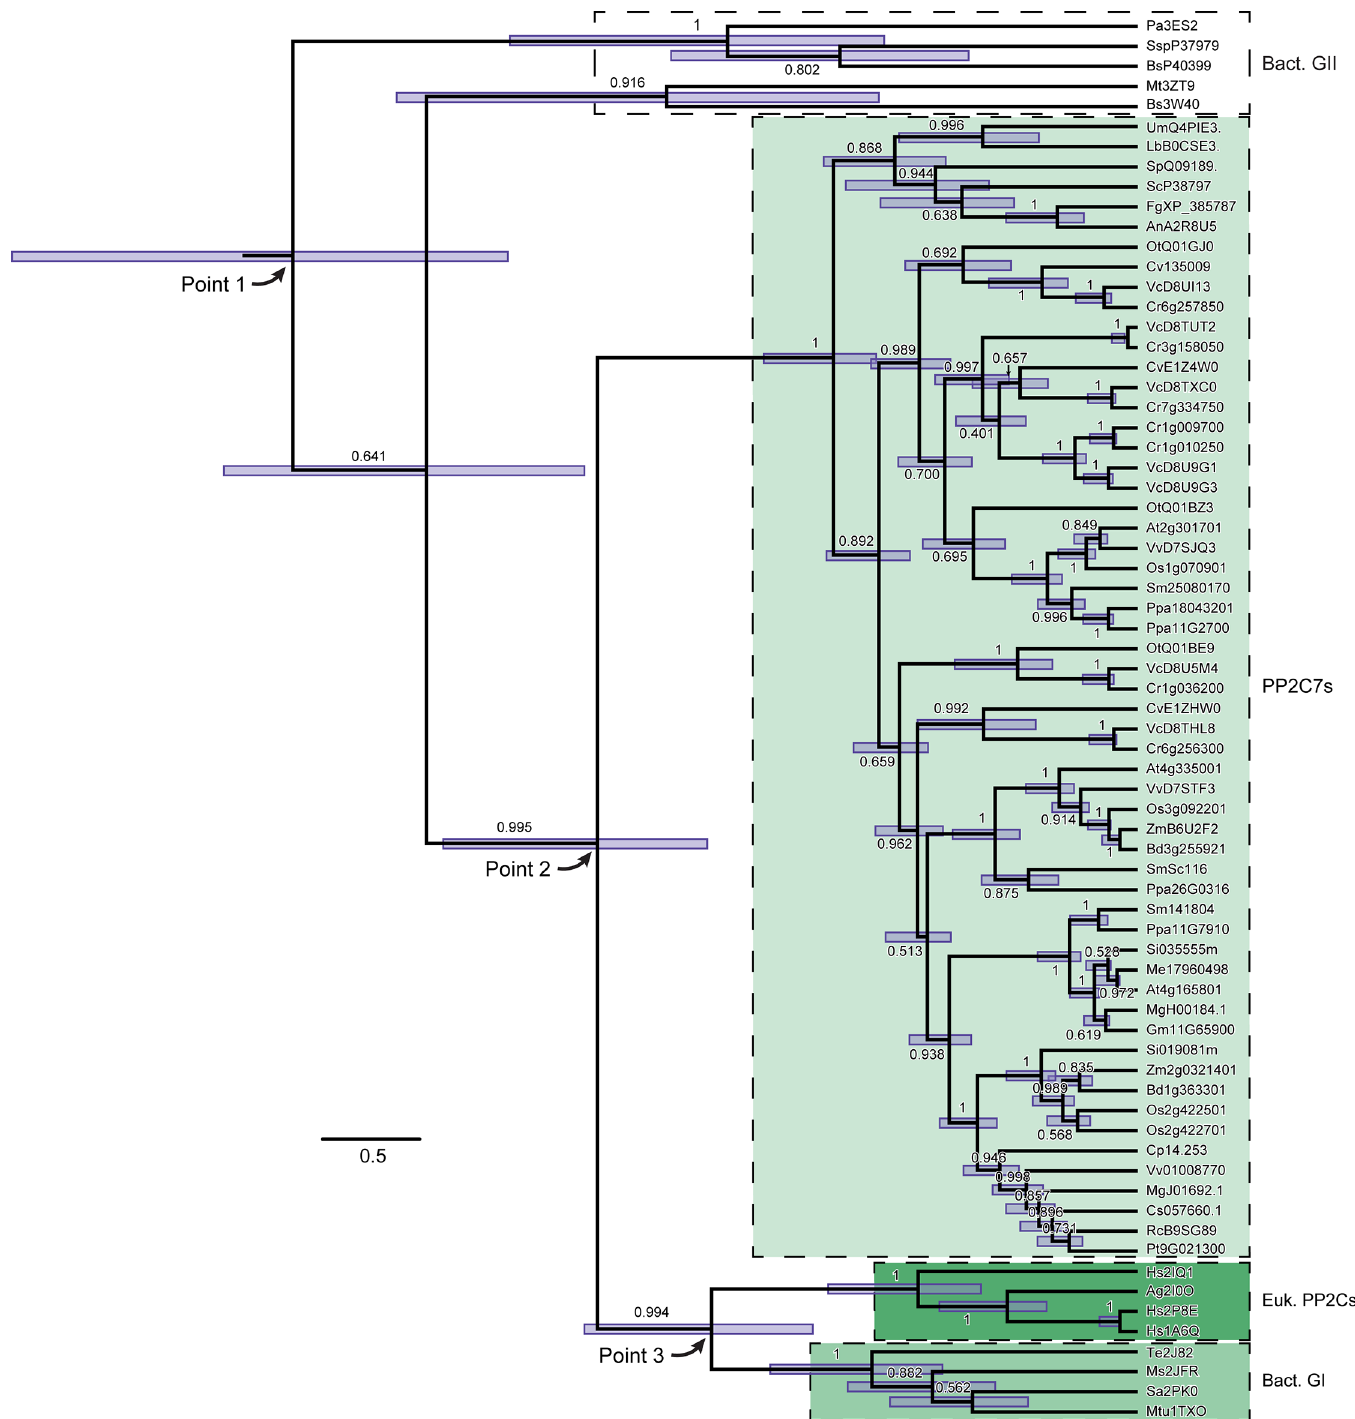
Fig 1. Phylogenetic orthogonal tree depicting major divergence points in the evolutionary history of modern PP2C sequences. A rooted phylogenetic tree was inferred using BEAST analysis, as detailed in “ Materials and Methods ” . Two independent chains were run from the same input file for 50 million cycles, collecting 10,000 trees each from the posterior distribution. A “ burn-in ” of 1,000 trees was discarded from each sample and the remaining trees pooled manually. The log files for the two runs were combined, and are available as supporting information (S4 File). In this figure the root is located in the upper left of the image. Depicted is the maximum clade credibility tree from the posterior distribution tree sample. Nodes display the 95% high posterior density interval in blue. Each branch is labeled with the posterior probability (max = 1.0). Point 1, Point 2 and Point 3 are discussed in the text. This tree is based on the amino acid sequence alignment presented in Fig A in S2 File, Panel 1.